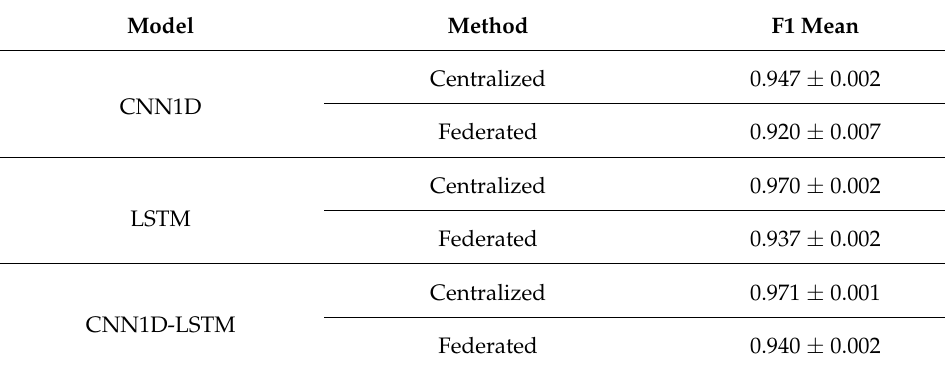
Table 7. Performance comparison by learning methods about the BGL